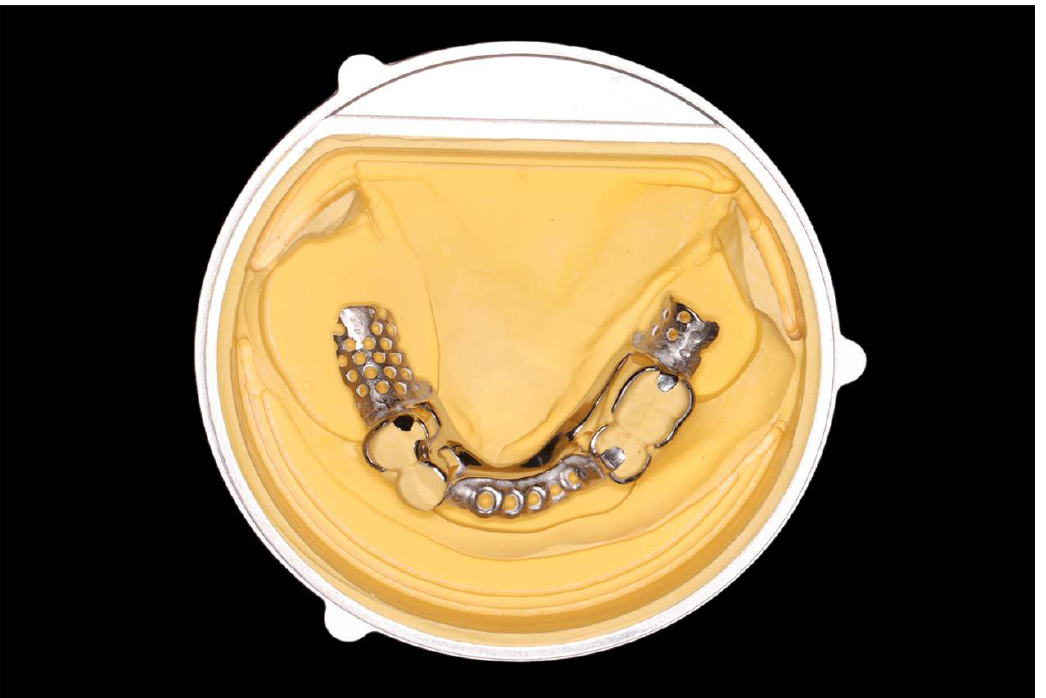
Figure 4. Metal framework seated on the modified cast within a metal jig.